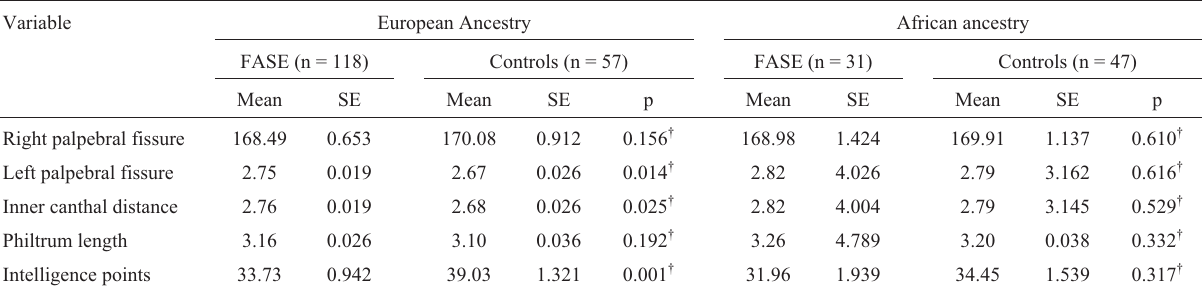
Table4 -Height,palpebralfissureslengthandinnercanthaldistancemeasures,andcognitiveperformanceinindividualsofEuropeanandAfricanances- try. Variable